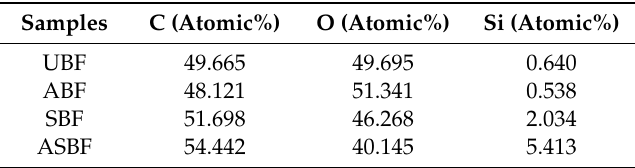
Table 2. Elements distribution on various BF